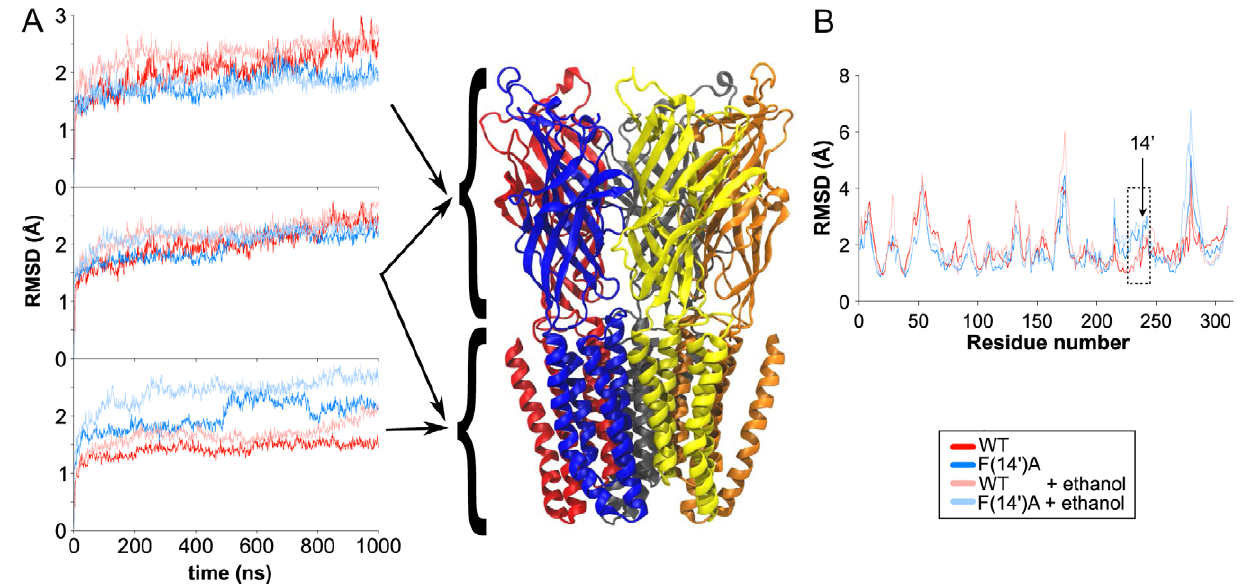
Figure 1. Structural deviation of GLIC simulations. ( A ) C a RMSD of the ECD ( upper panel ), whole protein ( middle panel ), and TMD ( lower panel ) for the WT (dark red), F(14 9 )A (dark blue), WT + ethanol (light red), and F(14 9 )A + ethanol (light blue) simulations relative to the GLIC crystal structure (PDB ID 3EAM). Right hand panel shows the GLIC structure colored by chain. ( B ) Average RMSD per residue over the four 1- m s simulations, colored as in (A). ECD includes residues 5 to 195, TMD residues 196 to 315. Box indicates high-RMSD residues 222–245, with residue 238 labeled according to M2 prime notation (14 9 ).